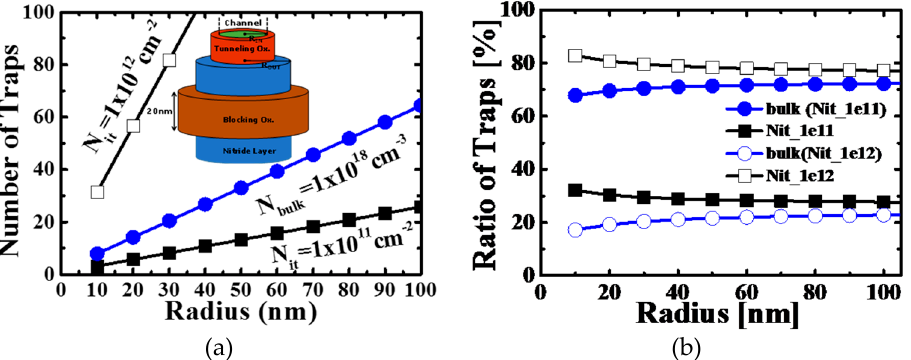
Figure 3. ( a ) Total real number of interfaces and bulk traps and ( b ) the percentage of traps depending on the channel radius of the cylindrical 3D SONOS device. Here, the radius (R in in inset figure) was in in the range of 10 to 100 nm, trapping layer thickness was 5 nm and gate length was 20 nm.